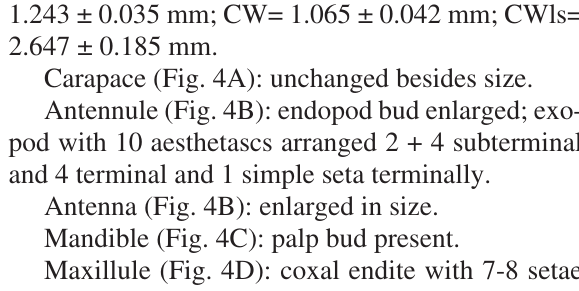
Pleopods (Fig. 3J’): second to fifth pleopods present as small biramous buds; sixth pleopod very small, hidden at the base of the telson.